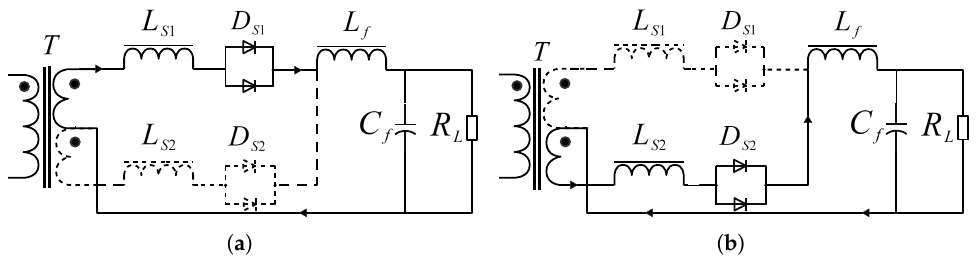
Figure 4. Working modes of the secondary circuit. ( a ) Stage I; ( b ) Stage